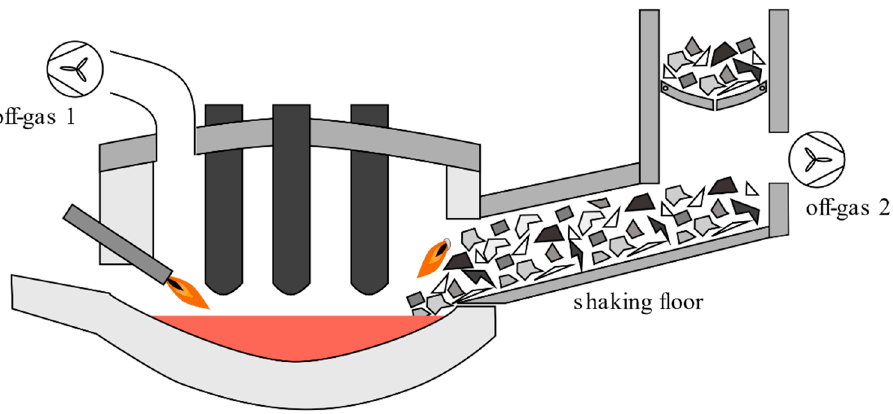
Figure 1. EAF off-gas preheating principle.